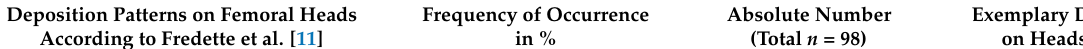
Table 3. Occurring deposition patterns on femoral heads.